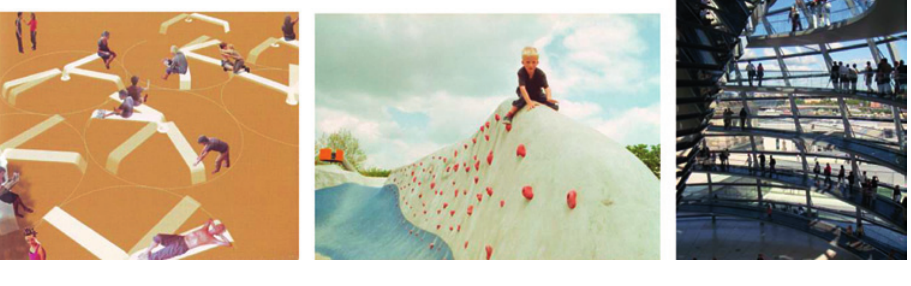
Fig. 25. Norman Foster. Berlin. 1999